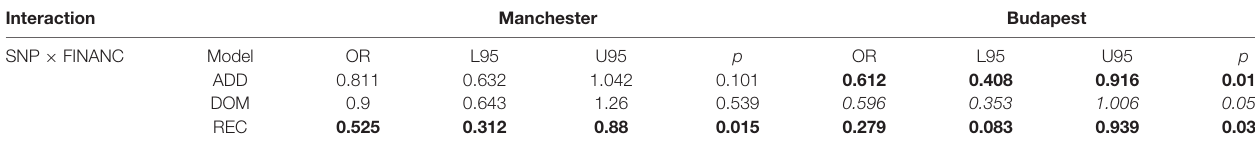
TABLE 3 | Statistical results of interaction effects between rs10462028 and financial hardship on migraineID in the subsamples. Interaction SNP × FINANC Model